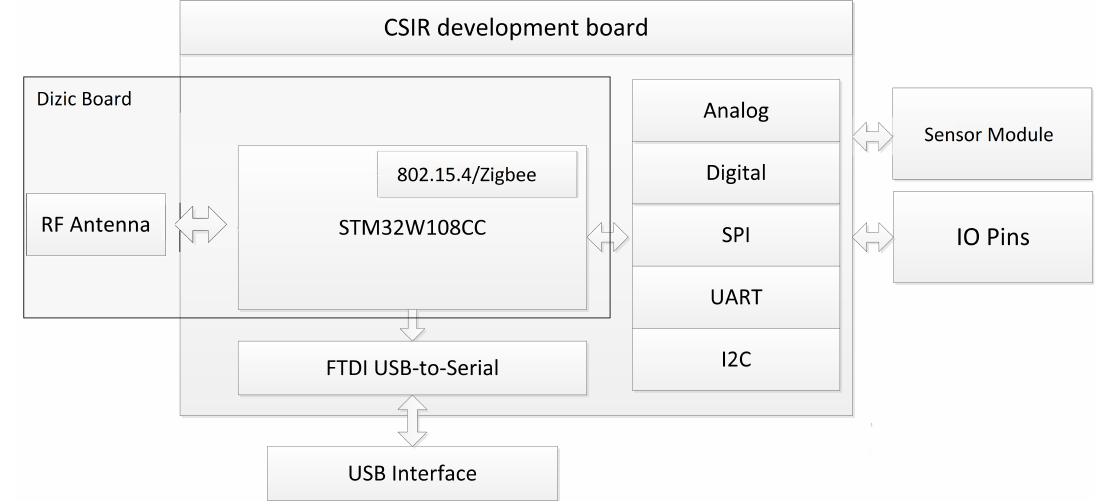
Figure 3. The CSIR Internet of Things node functional